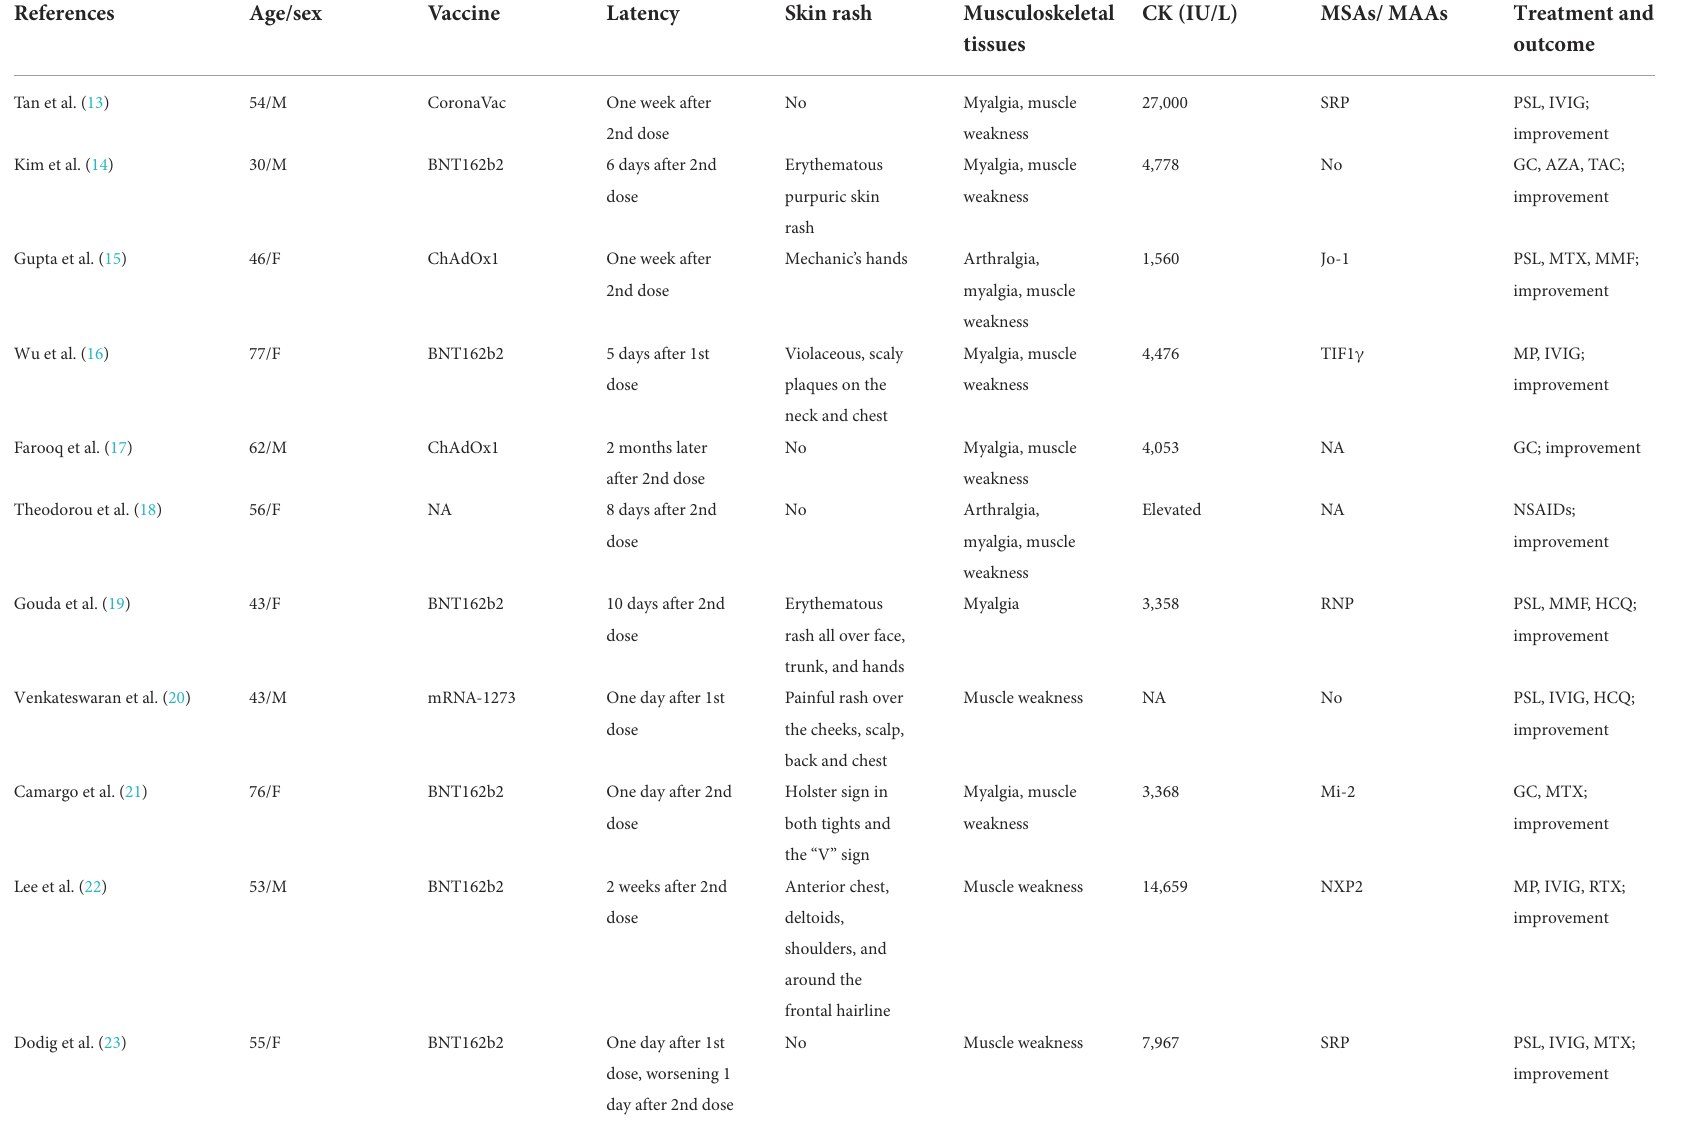
TABLE 1 Clinical and laboratory findings of IM patients following COVID-19